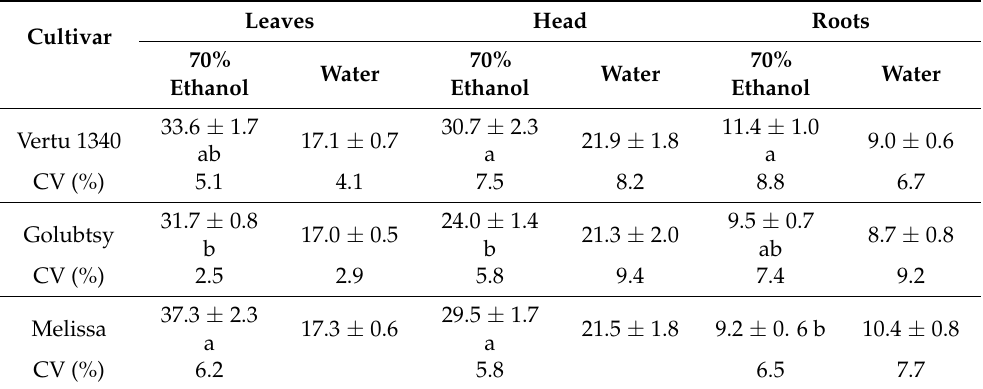
Table 5. Mean values of polyphenol content in ethanol and water extracts of Savoy cabbage leaves, head, and roots (mg GAEg − 1 d.w.).